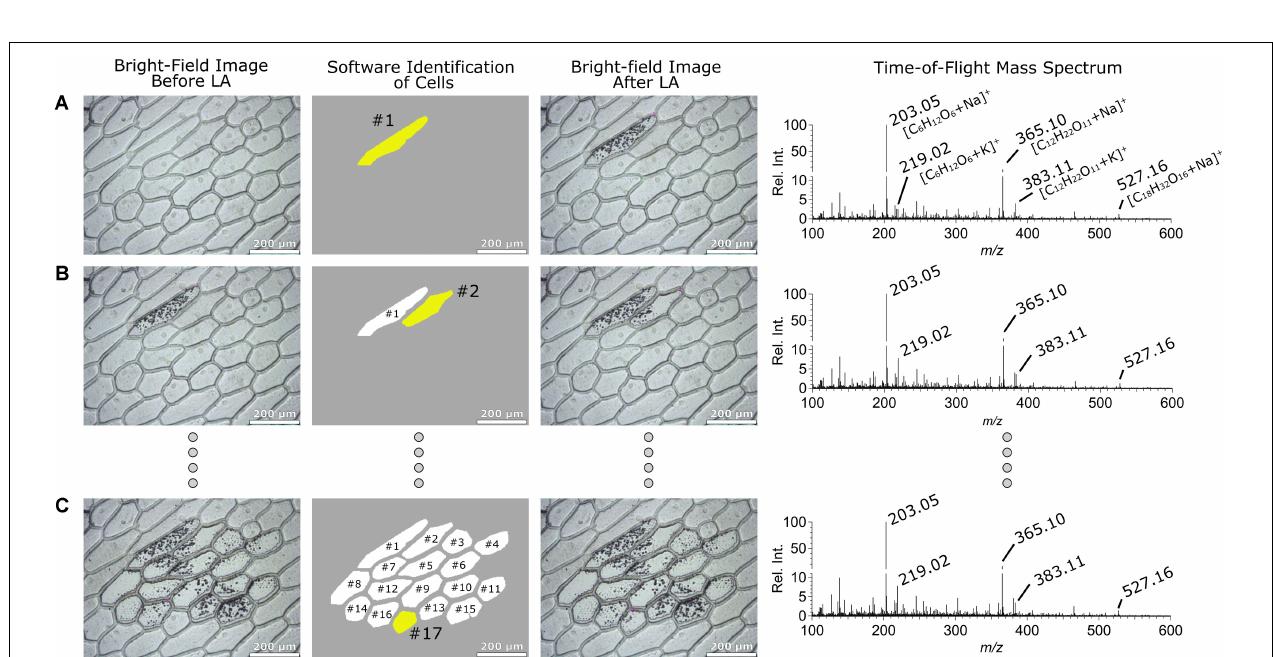
FIGURE 2 | Bright-field optical images of the sampled Allium cepa epidermis tissue before ( column 1 ) and ( column 3 ) after sampling. The cell marked with yellow in column 2 represents the cell analyzed ( white cells indicates previously analyzed cells) by LA-LVC/ESI-MS analysis and column 4 represents the corresponding positive ion mode ESI-MS TOF mass spectra. The sampled cells were #1, #2, and #17 in (A–C) , respectively.